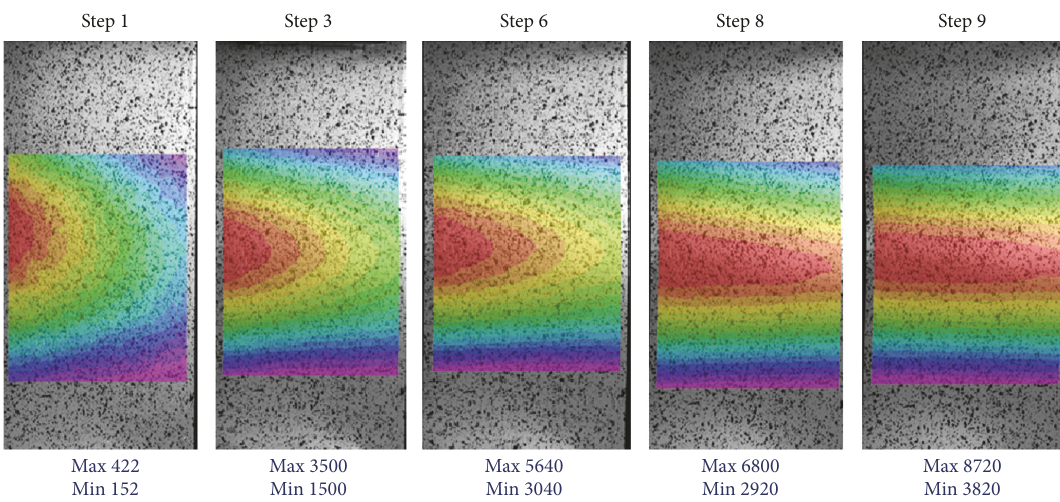
Figure 15: Out-of-plane displacement-principal step-side delamination specimen [ 𝜇𝜀